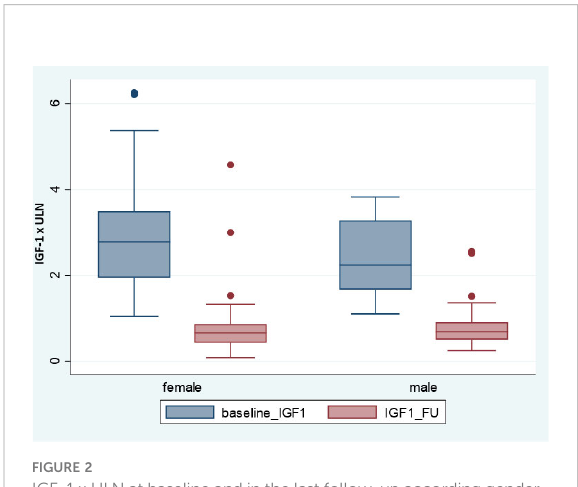
FIGURE 2 IGF-1x ULN at baseline and in the last follow-up according gender.